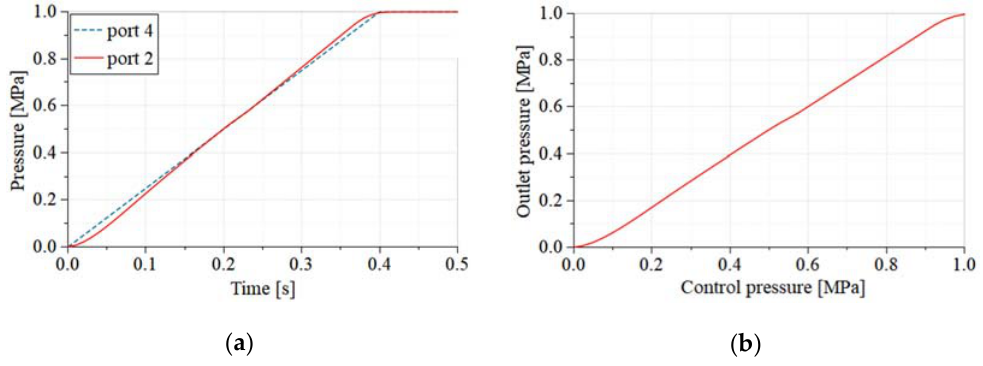
Figure 13. Characteristic curves of the relay valve. ( a ) Pressure of the control port and the outlet port; ( b ) relationship of the outlet pressure and control pressure. Port 2 is the outlet port. Port 4 is the control port.